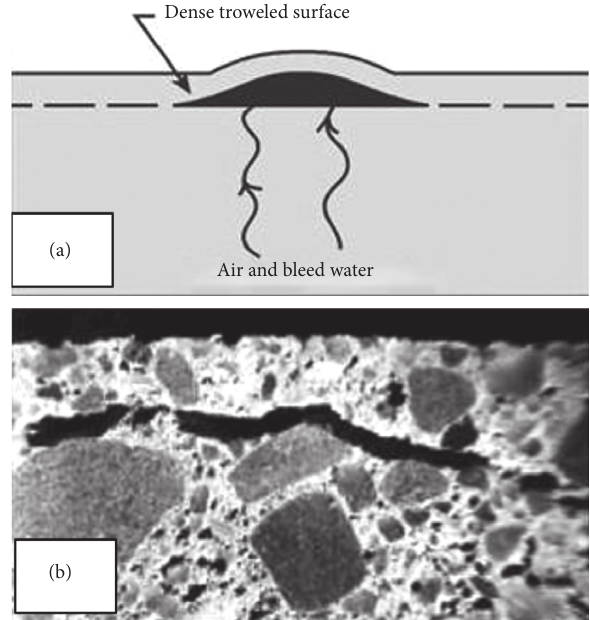
Figure 13: Effect of bleeding below the upper layer of concrete: (a) schematic draft; (b) 5x photo.